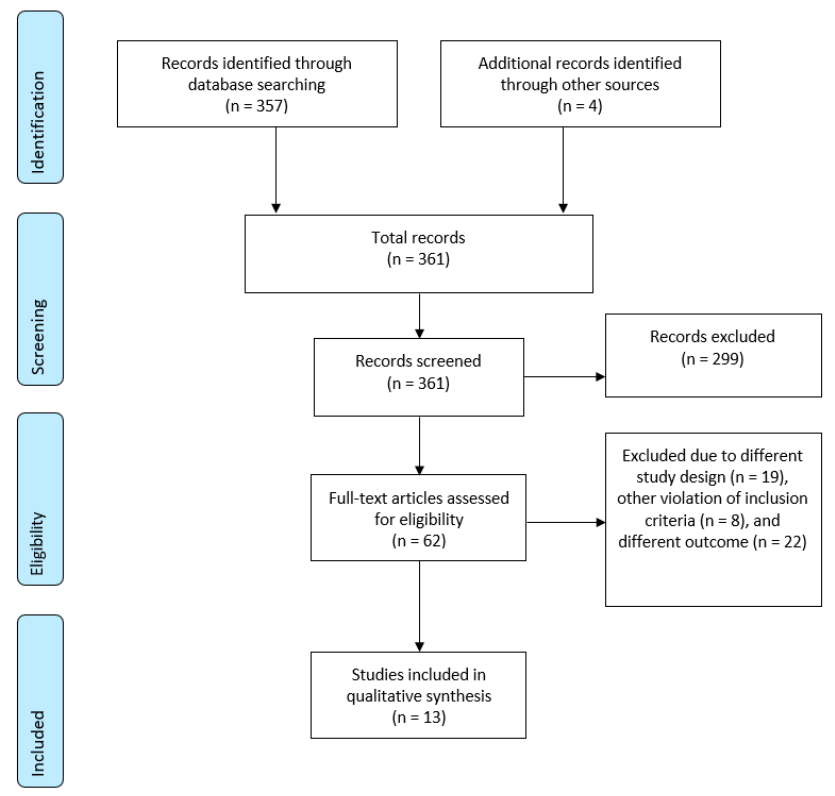
Figure 1. Flow diagram of the systematic literature search. Preferred Reporting Items for Systematic Reviews and Meta-Analyses (PRISMA) flow diagram shows the number of records identified, included, and excluded through the di ff erent phases of a systematic